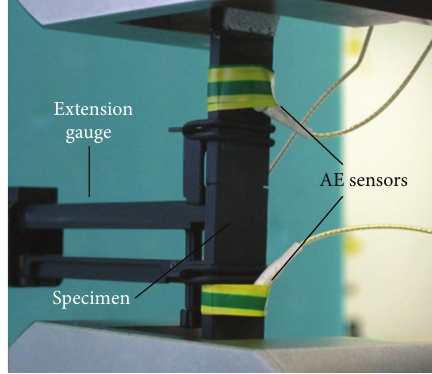
Figure 2: Snapshot during experiment.